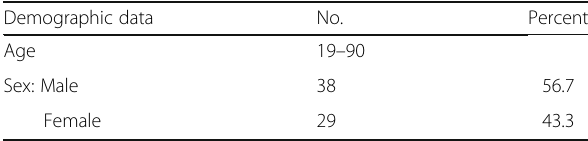
Table 1 Demographic data of the